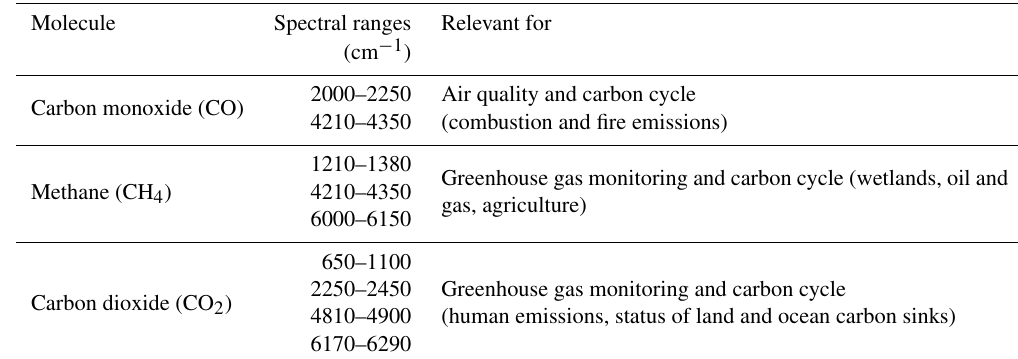
Table 3. Spectral ranges used in this study for simulated retrievals of CO, CH 4 , and CO 2 . Molecule Spectral ranges Relevant for (cm − 1 ) Carbon monoxide (CO)